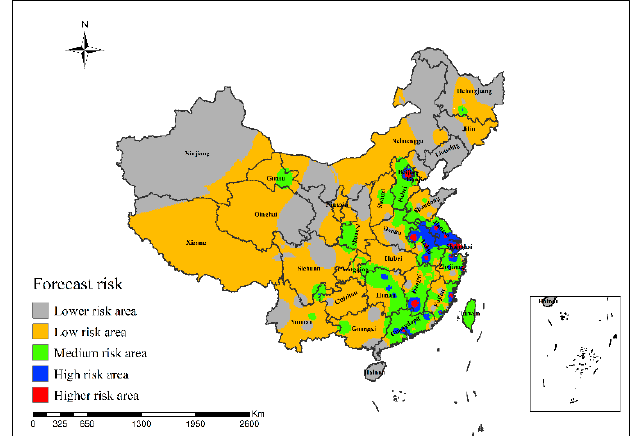
Figure 14. Risk simulation results of H7N9 outbreaks in China in 2014.